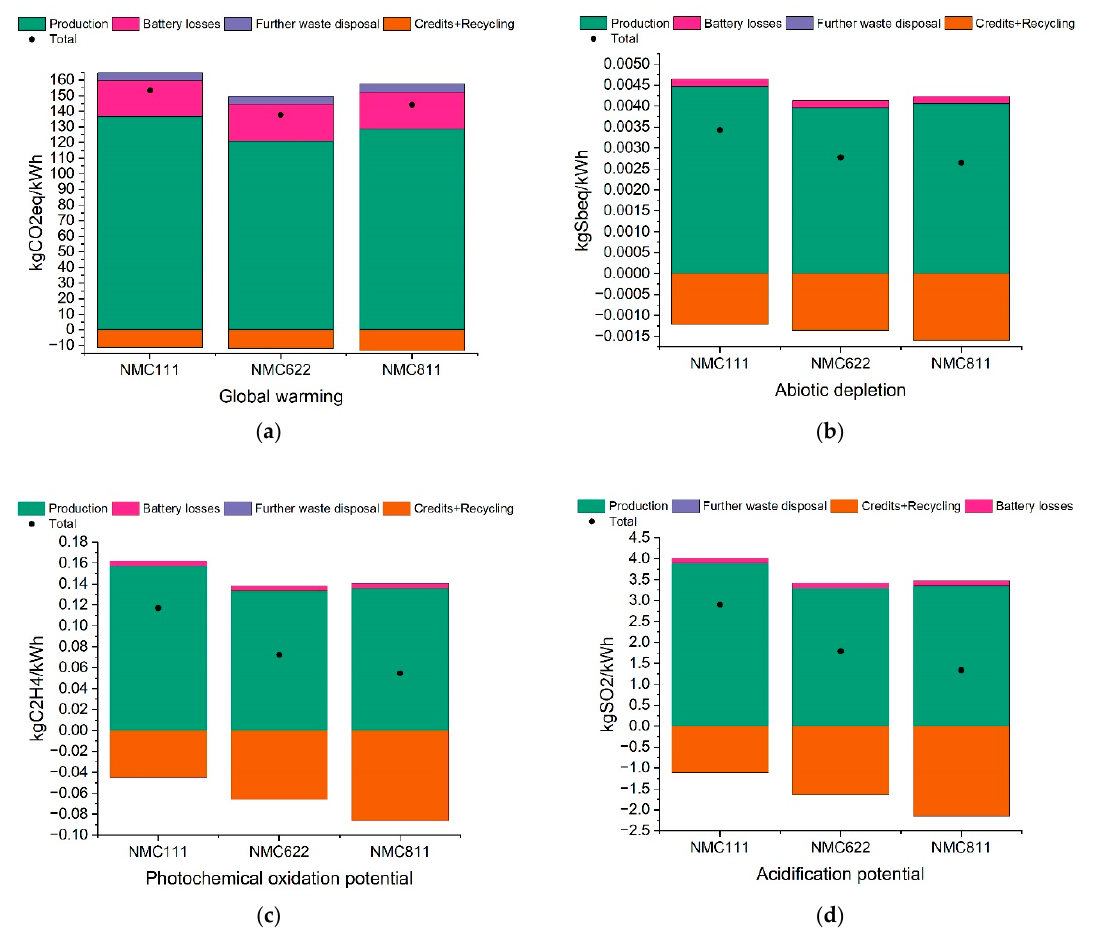
Figure 5. Impacts per kWh of different NMC chemistries ( a ) for the global warming potential (GWP) impact; ( b ) for the abiotic resource depletion potential (ADP) impact; ( c ) for the photochemical oxidation potential (POP) impact; ( d ) for the AP impact.